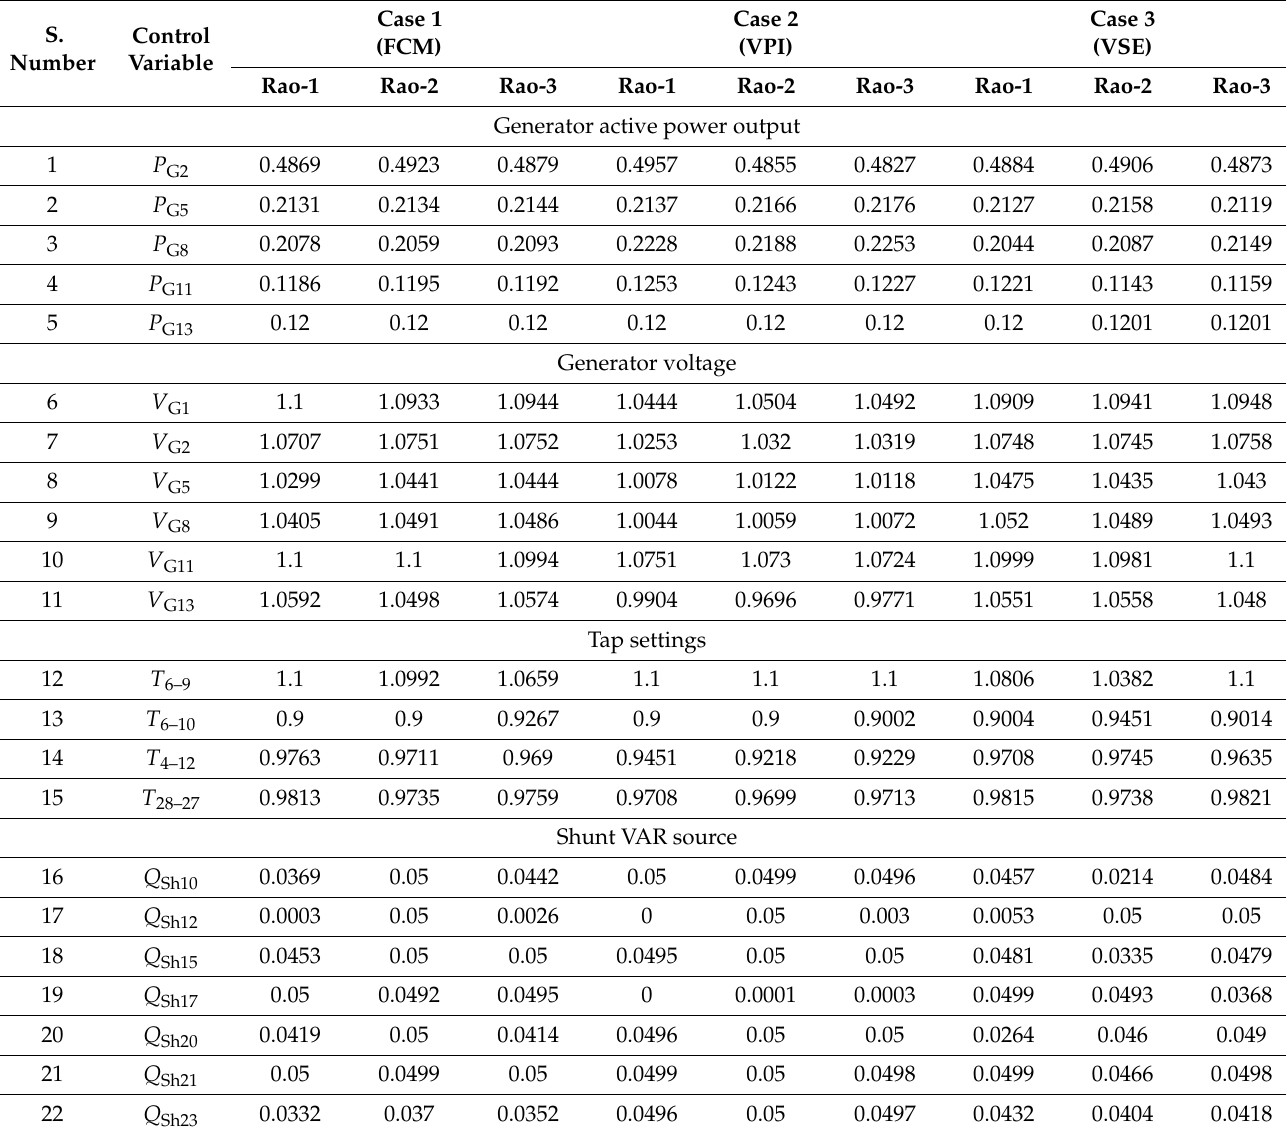
Table 3. Optimum values of control variables for Case 1, Case 2, and Case 3 of the IEEE 30-bus system.